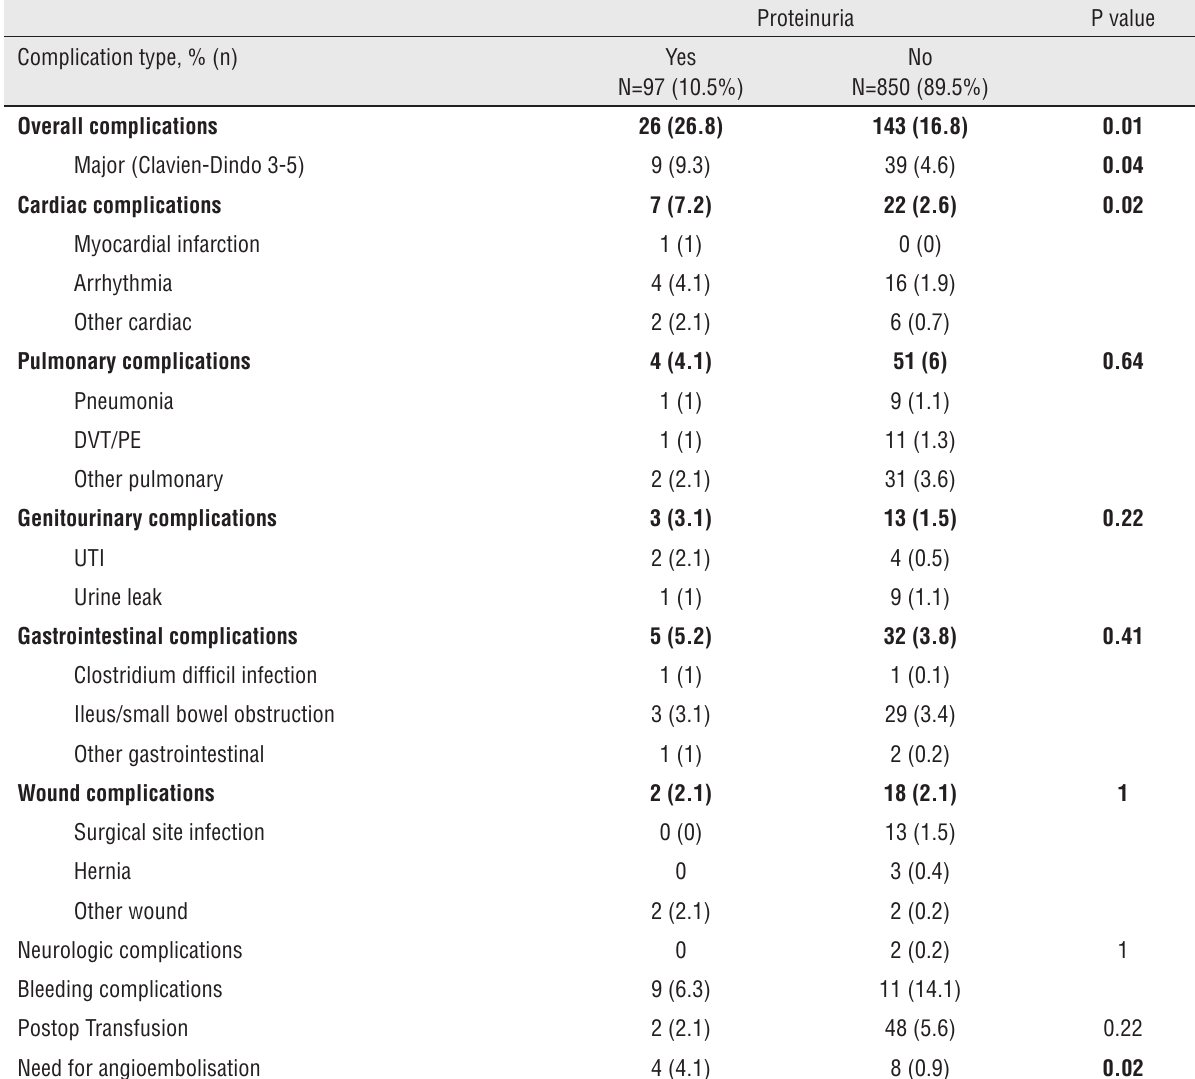
Table 4 - Summary of complications based on preoperative